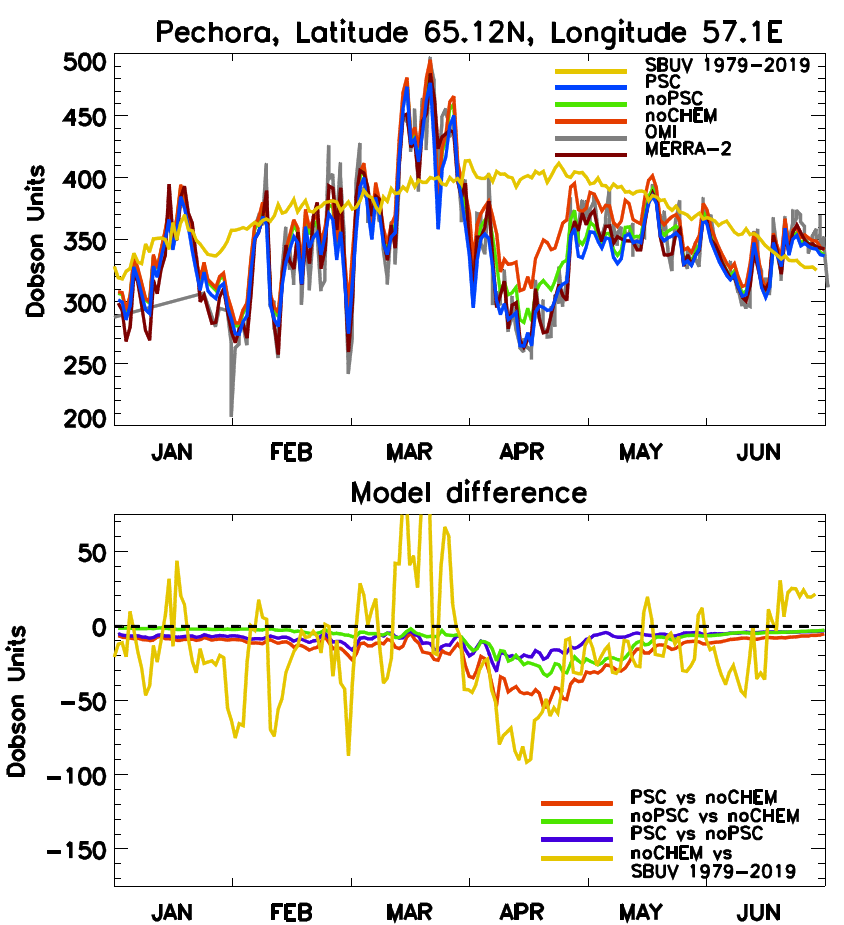
Figure 7. Column Ozone variability at Pechora Station for the first half of 2020 ( top ): SBUV mean over 1979–2019 (yellow), OMI data (gray), CTM basic scenario (PSC) (blue), CTM scenario without PSC processes included (noPSC) (green), CTM scenario with no chemical ozone destruction included (noCHEM) (red); and column ozone difference between CTM simulation for several scenarios ( bottom ): noCHEMall and SBUV 1979–2019 averages (yellow), PSC and noCHEM (red), and PSC and noPSC (blue). By the end of March, when the polar vortex returns to the Eastern Hemisphere, total ozone content at Pechora drops by almost 50 percent, reaching values about 250 DU.